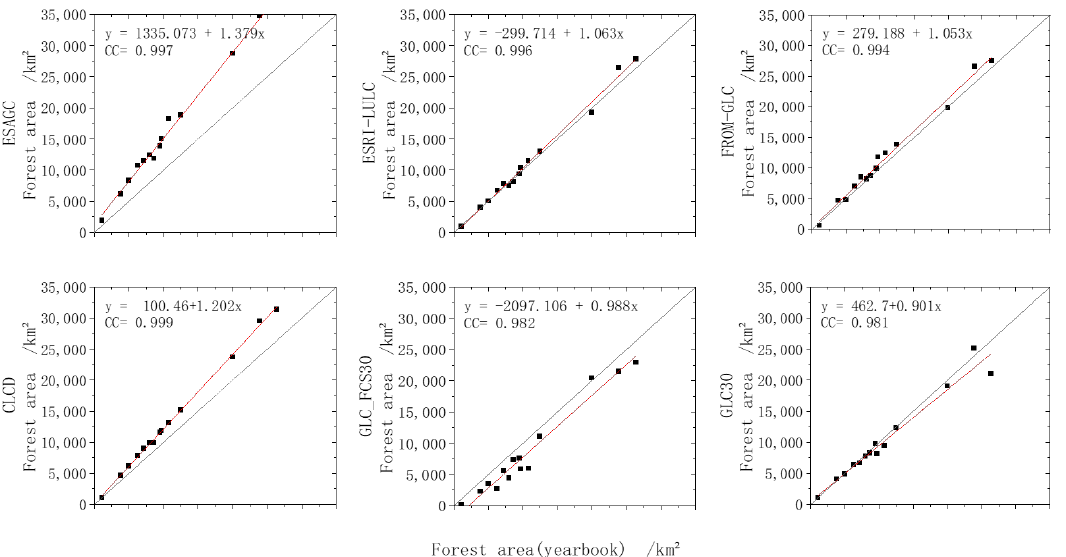
Figure 5. Scatter plots showing a comparison of the forest area at the municipal level in Guangxi between the six land cover data sets and the statistical yearbook data.